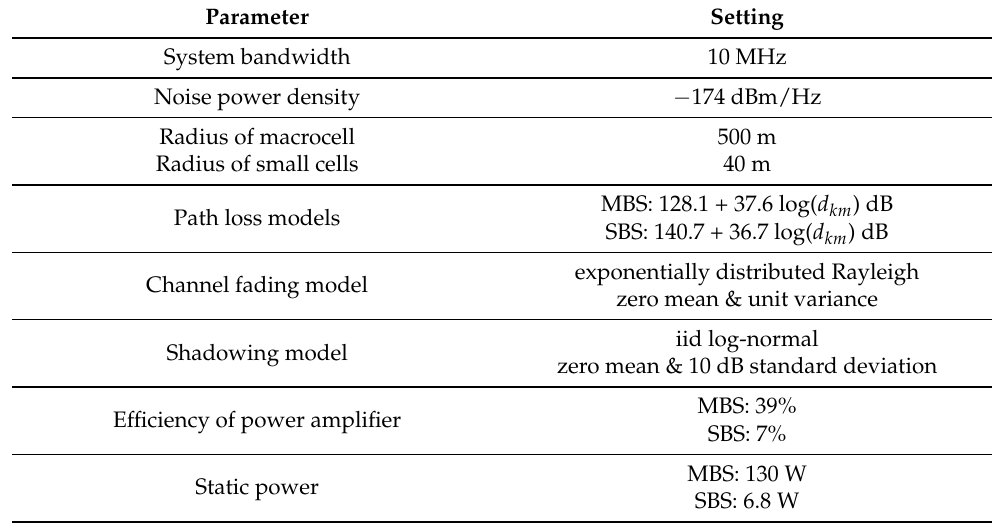
Table 4. Setting of the simulation parameters.